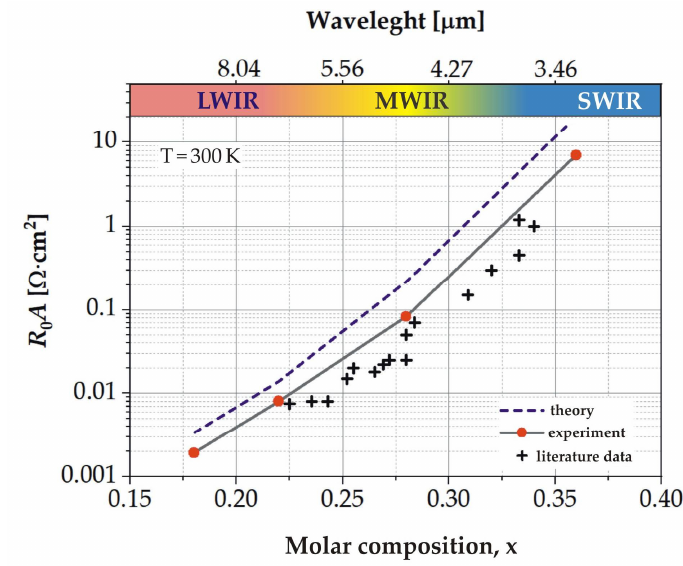
Figure 13. Theoretical and experimental data of the R 0 A product as a function of molar Cd composi- tion x at room temperature. Literature data are from [1].